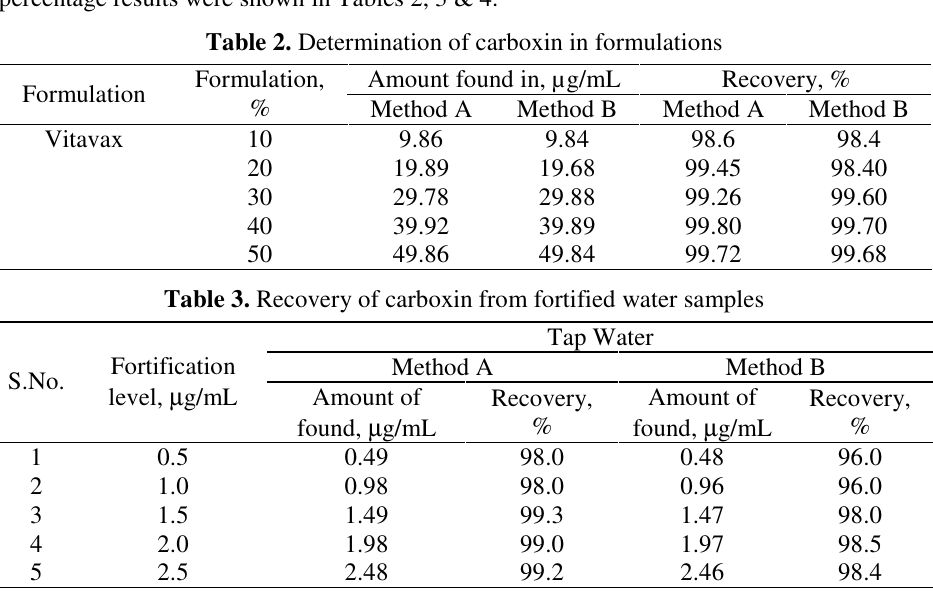
Table 4. Recoveries of carboxin added to (food grains) soyabeans and